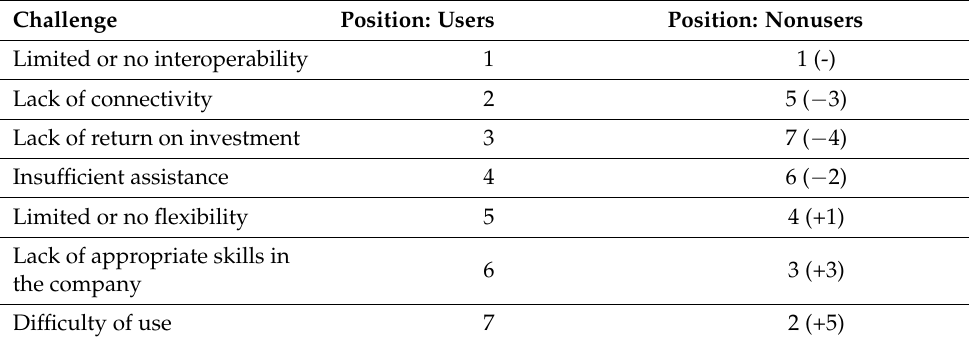
Table 13. Relative position of challenges.